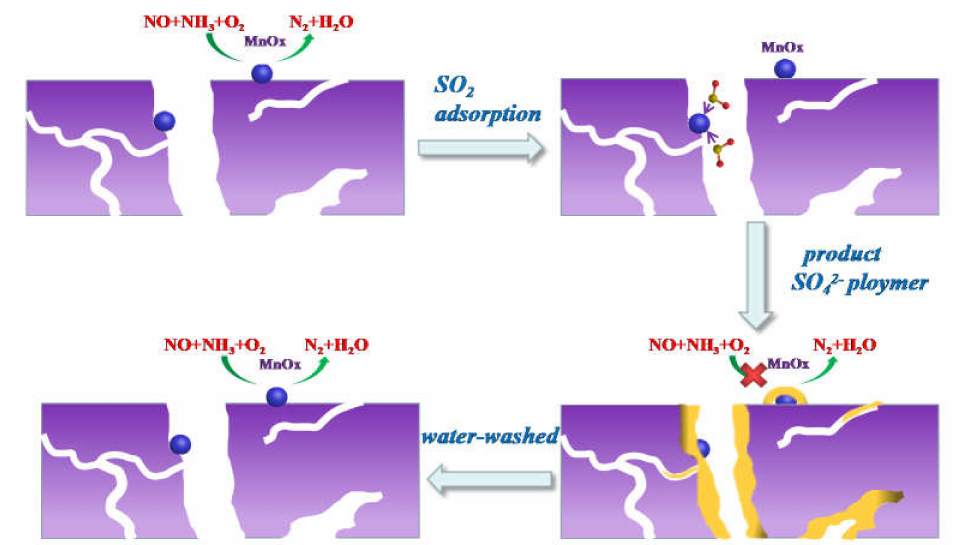
Figure 13. Proposed sulfur-treated poisoning and water-washed regeneration mechanism